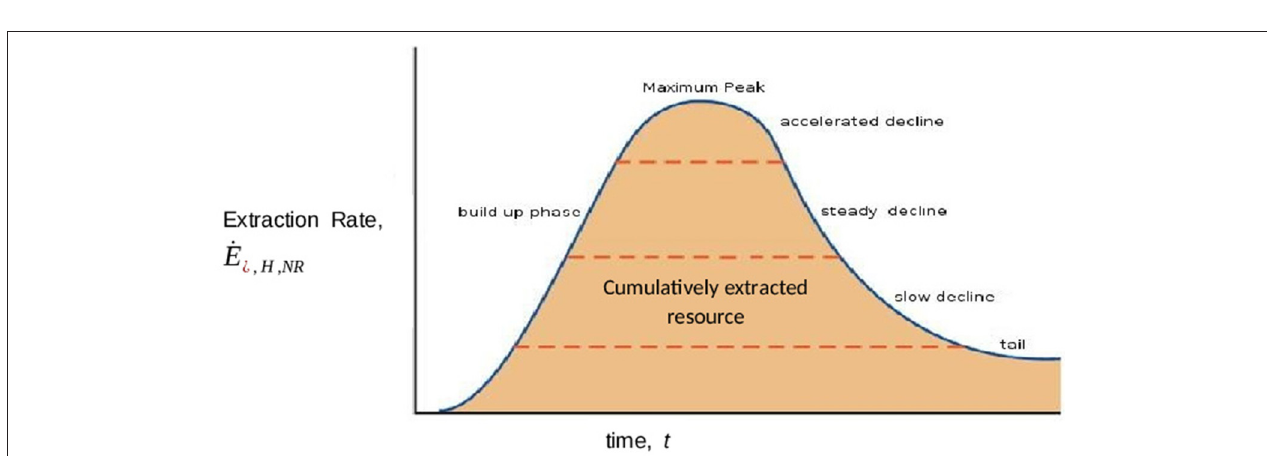
FIGURE 3 | The closed-system model of society/environment interaction.